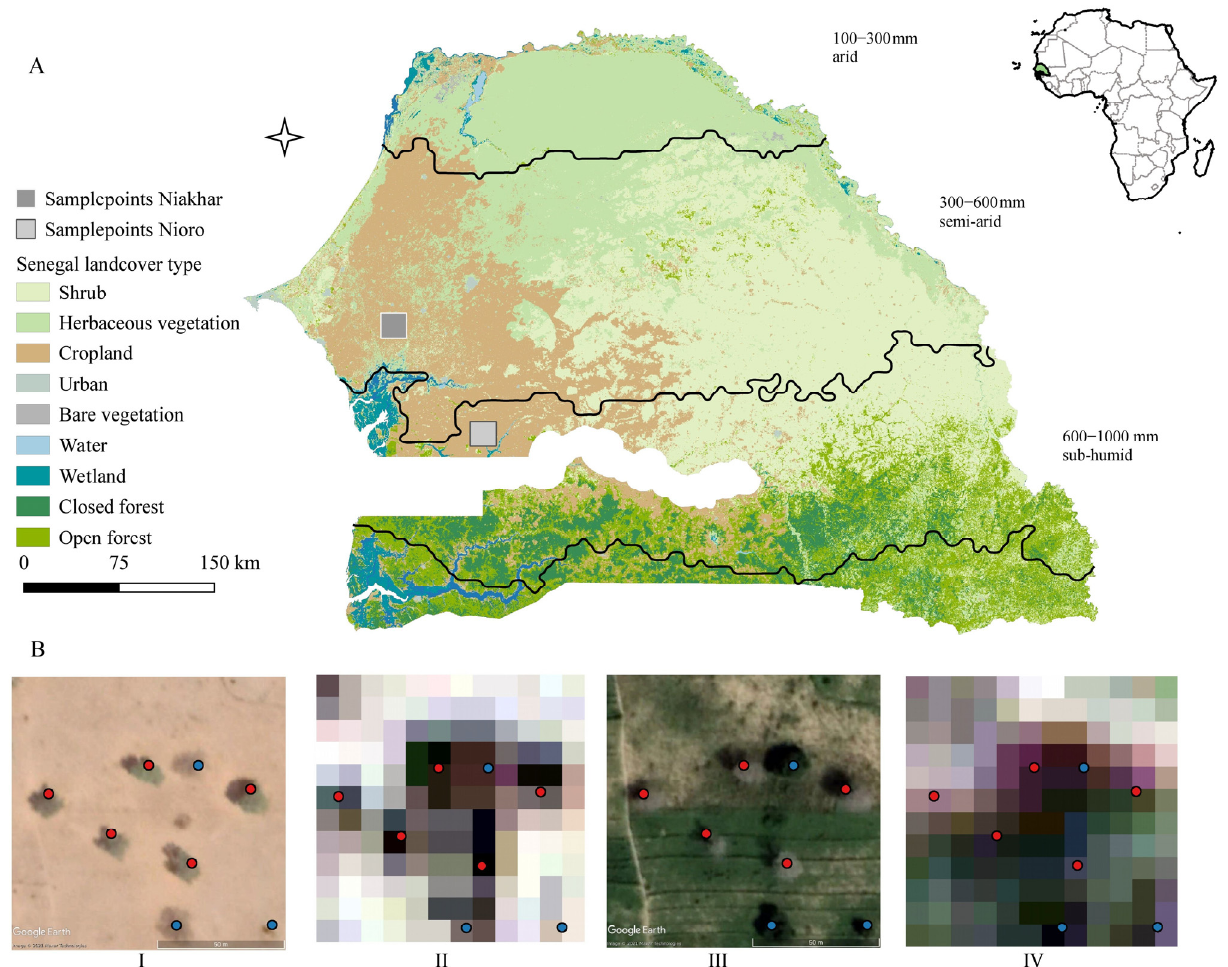
Figure 1. ( A ) Location of Senegal and land use/cover map of 2019 (Copernicus Global Land Service at 100-m resolution). The precipitation data are derived from the CHIRPS long-term (1981–2019) yearly average. The rainfall zones of 100–300 mm, 300–600 mm and 600–1000 mm are categorized as arid area, semi-arid area and sub-humid area. The two grey boxes represent locations of data sampling in Niakhar and Nioro. ( B ) Examples of Faidherbia albida trees (red dots) during the (I) dry and (III) rainy season from Google Earth. Image (II) and (IV) represent the corresponding stretched true colour images from Sentinel-2 at 10-m resolution. Blue points represent other tree